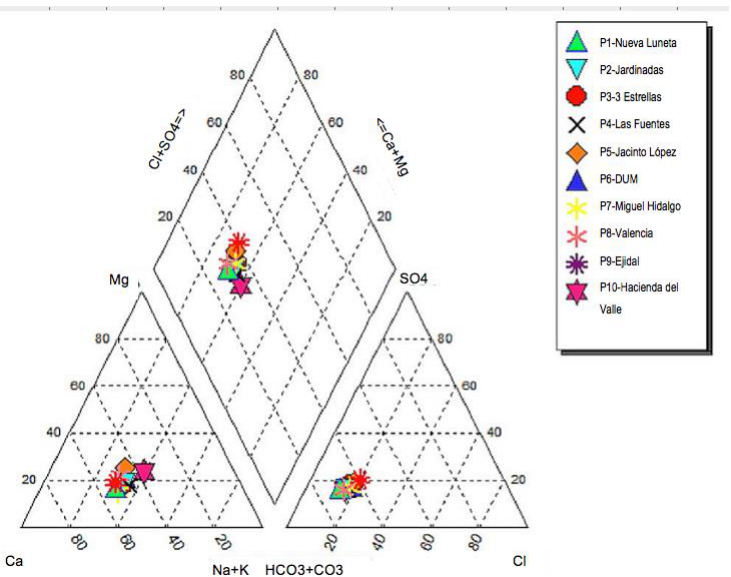
Figure 5. Piper diagram of the studied sites.